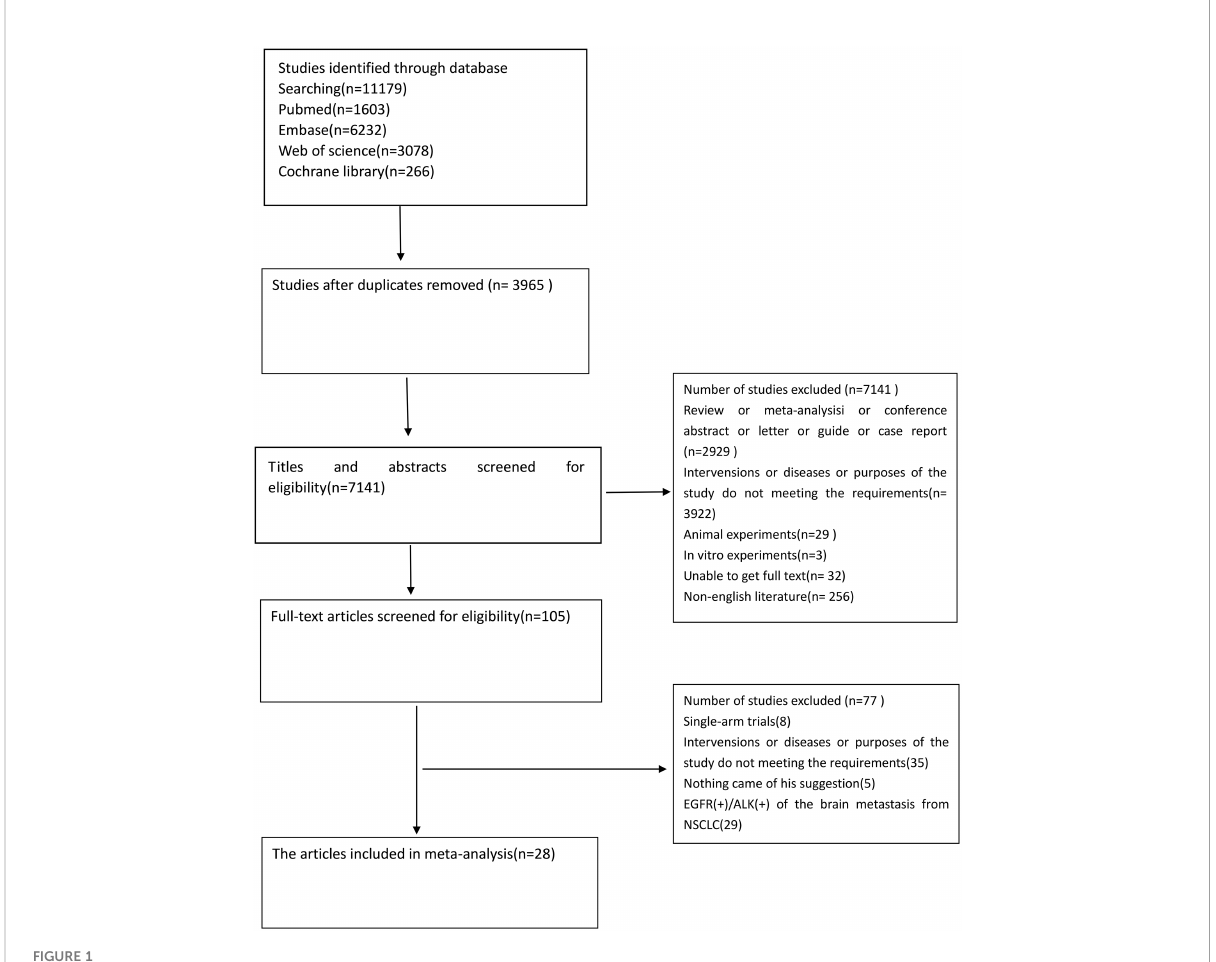
FIGURE 1 Flow diagram for the selection of the